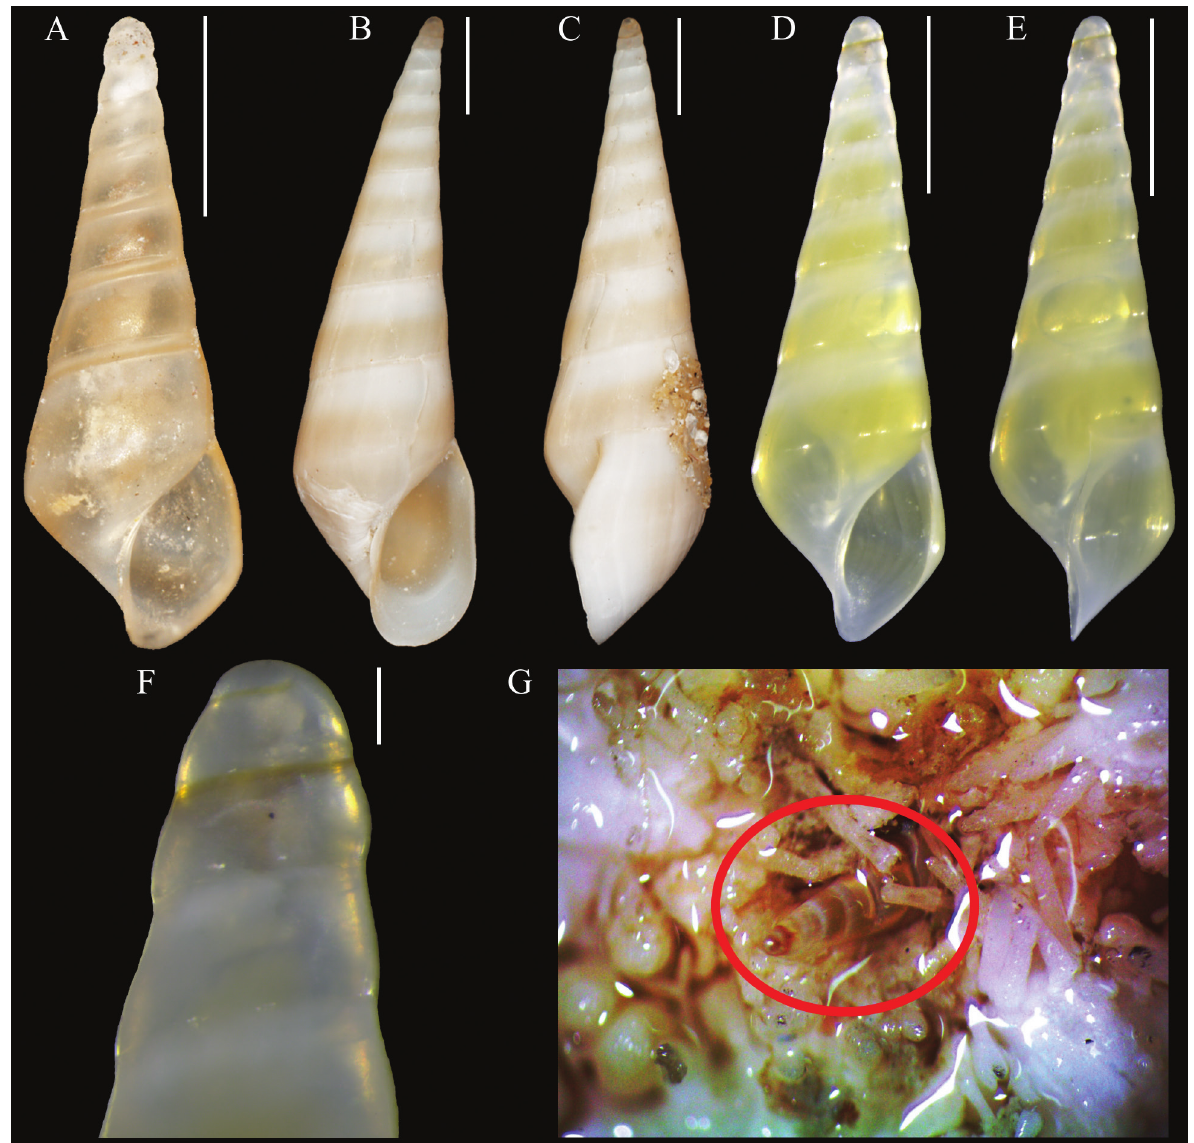
Figure 1. Eulimacrostoma microsculpturata gen. nov. and sp. nov. A. Holotype (USNM 429762); B, C. Paratype (USNM 433081); D–G. Paratype (FLMNH uncatalogued.) A, B, D. Shell in frontal view; C, E. Shell in lateral view; F. Detail of apical whorls in frontal view; G. Specimen attached to the host Luidia ludwigi scotti Bell, 1917 (Echinoderm collection, FLMNH 5042), red ellipse indicates the eulimid. Scale bars: 1 mm (A–E); 100 µm